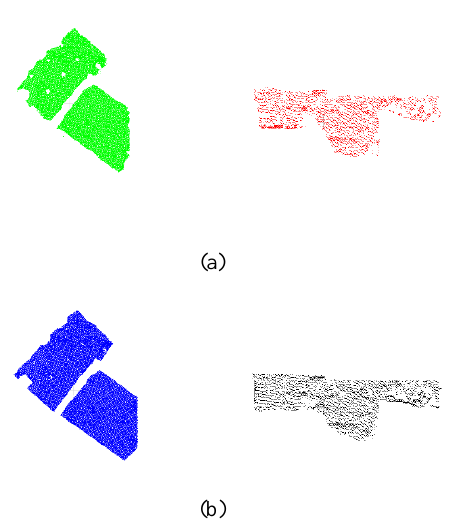
Figure 11: Building 3 segmentation of roof (left) and facade (right) (a) Proposed segmentation, (b) Manual segmentation